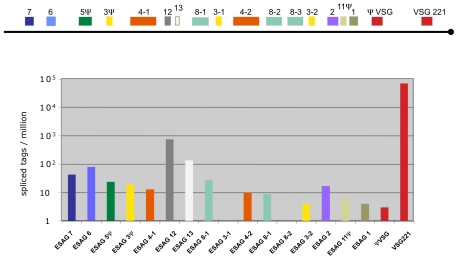
Expression levels of genes in the active VSG expression site.Schematic representation of the tag frequency distribution in the bloodstream expression site 1 (BES1/TAR40), as annotated by Hertz-Fowler et al.
[31]. The hypothetical gene between ESAG 12 and ESAG 8-1 encodes a protein of 96 amino acids and is renamed ESAG 13.